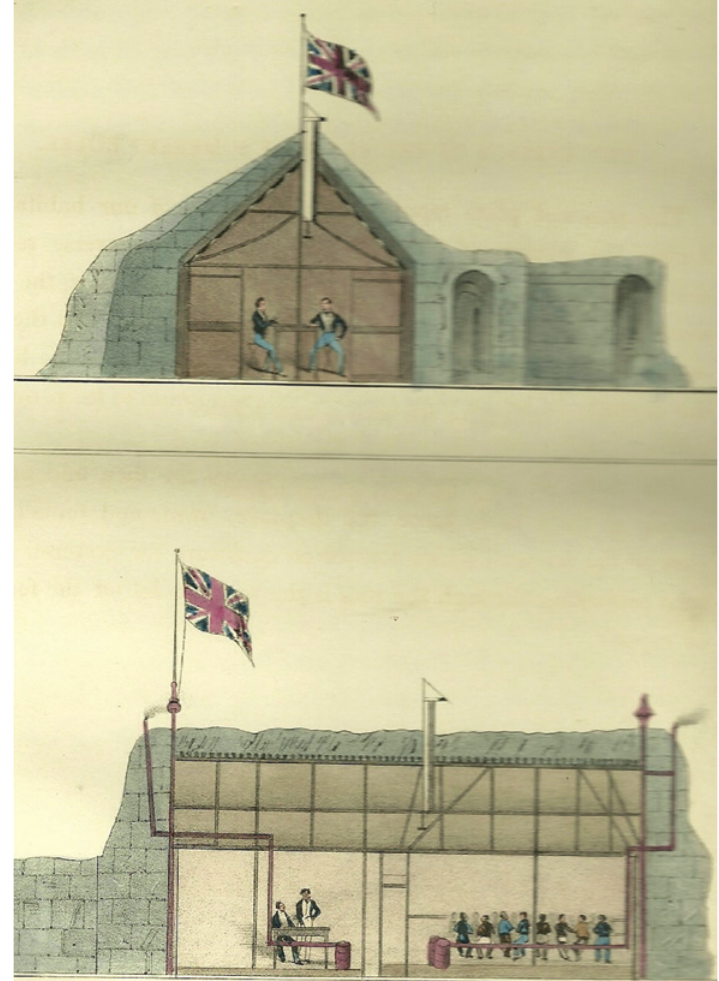
Figure 8. ‘Somerset House’, where Ross’s crew spent the last winter . Source : Ross, Second Voyage ,